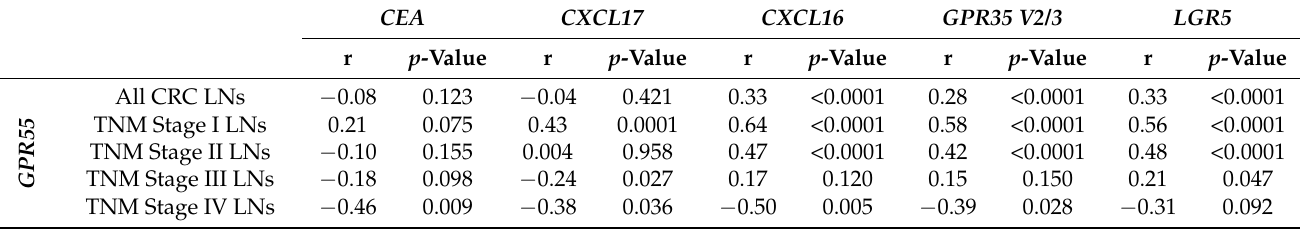
Table 1. Correlations between GPR55 mRNA expression levels and expression levels of other biomark- ers in the lymph nodes of CC